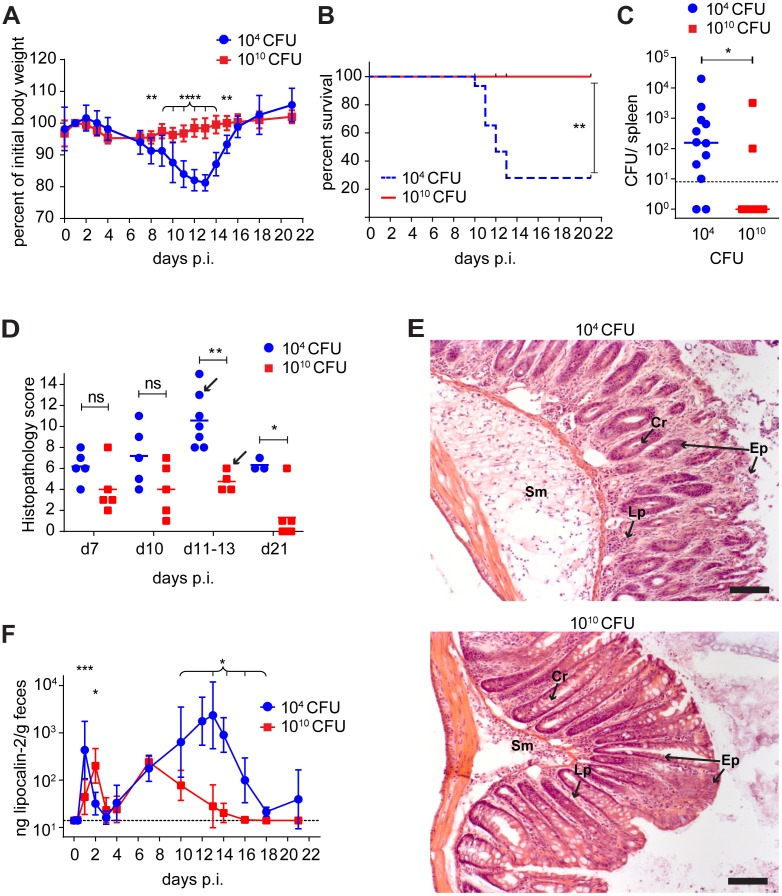
High-dose C. rodentium infection is associated with reduced severity of disease in germ-free wild-type mice.(A) Body weight of germ-free mice infected with either 104 (blue circles) or 1010 (red squares) CFU/mouse of C. rodentium, (n = 15 until day 10). (B) Survival curve of the animals shown in A. (C) Splenic bacterial loads of mice shown in A infected with 104 (blue circles) or 1010 (red squares) CFU/mouse of C. rodentium for 10–13 days; n = 10–12 per group. (D) Histopathological scores of mice shown in panel A (Endpoint criterion: weight loss of >20 %). Mice were scored for epithelial hyperplasia and integrity, infiltration of PMNs, submucosal edema, and loss of goblet cells. Graph shows combined score (= sum of 5 individual scores). (E) Representative images of colonic histopathology scored in panel D (H&E staining) of mice infected for 13 days with 104 (top) and 1010 (bottom) CFU. Arrows in panel D indicate the individuals depicted. Scale bar: 100 μm; Sm, submucosa; Cr, crypts; Ep, epithelium; Lp, lamina proria; (F) Lipocalin-2 measurement by ELISA in feces from infected mice (n = 5 per group, same animals as shown in A; after day 13 n = 3 survivors in 104 group). Error bars indicate standard deviation. Dotted lines indicate detection limit; ns, statistically not significant; *, p < 0.05; **, p < 0.01; ***, p < 0.001; ****, p < 0.0001; statistical tests: Student`s t-test (A), Mantel-Cox test (B), Mann-Whitney U test (C, D, F).